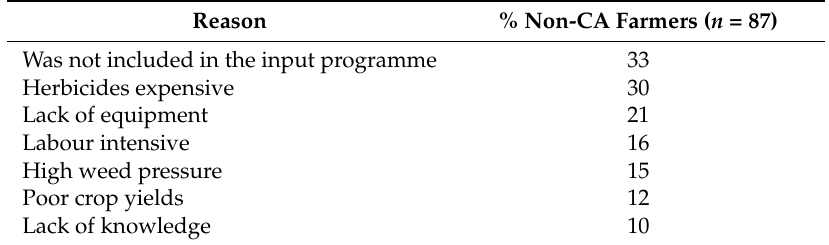
Table 8. Constraints to practise of CA by the sampled smallholder farmers of the Eastern Cape